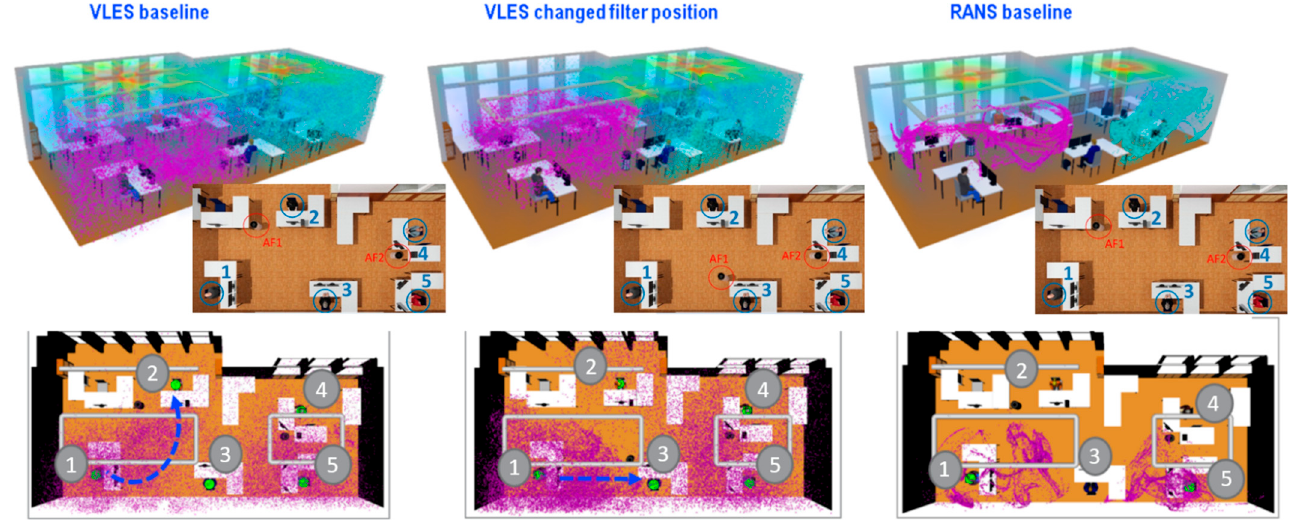
Figure 17. Distribution of the particle concentration for a coughing scenario simulated after 75 s using different simulation methods and positions of the air cleaner.